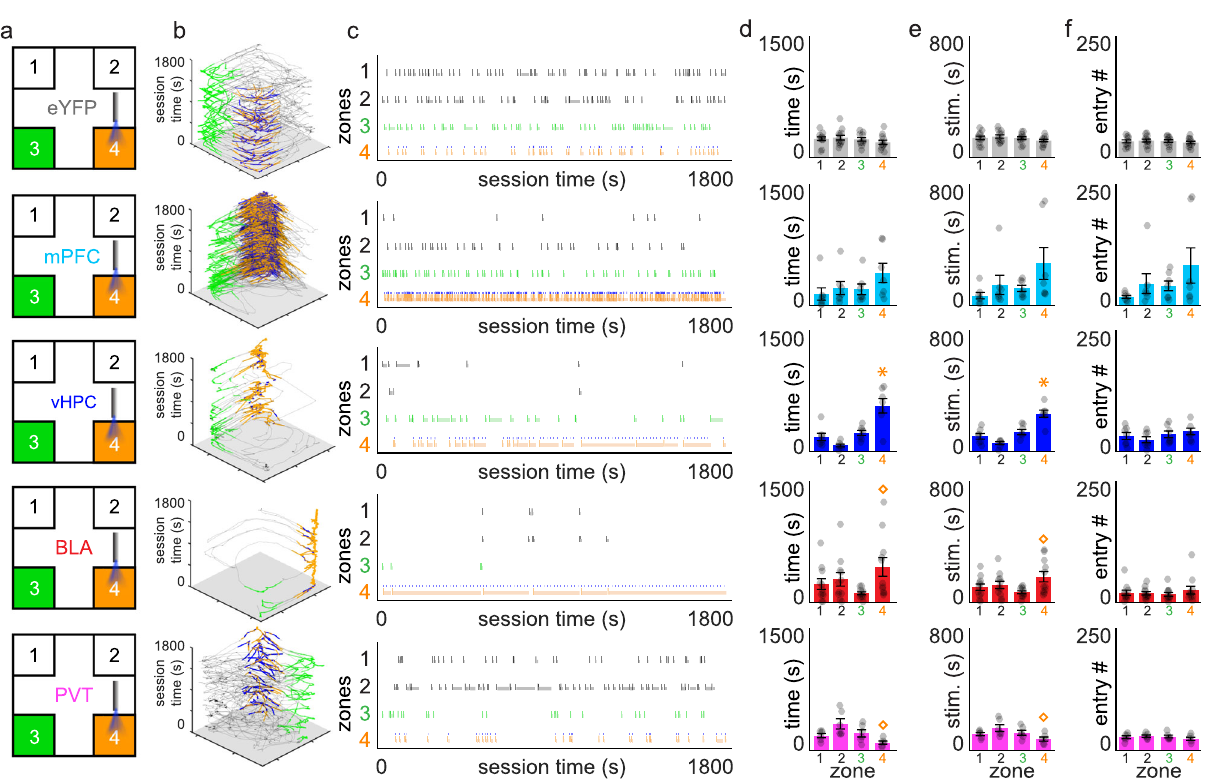
Fig. 3 Expression of NAcSh input-speci fi c behavioural strategies during reversal testing. Different NAcSh input groups are depicted by different colours throughout: eYFP controls (gray, n = 12 mice), mPFC → NAcSh (cyan, n = 7 mice), vHPC → NAcSh (blue, n = 7 mice), BLA → NAcSh (red, n = 11 mice), and PVT → NAcSh (pink, n = 6 mice). a Following acquisition, mice explored the testing arena with a new active zone (4; orange). Inactive zones included the previously active zone (3; green) and zones 1 and 2 (black). b x – y position tracking for representative mice throughout the session (orange = position in active zone; blue = position during stimulation; green = position in previously active zone). c Raster plots showing individual zone entries over time in representative mice (same mice as in b). Orange shading indicates time spent remaining in the active zone. d Total time spent across the four